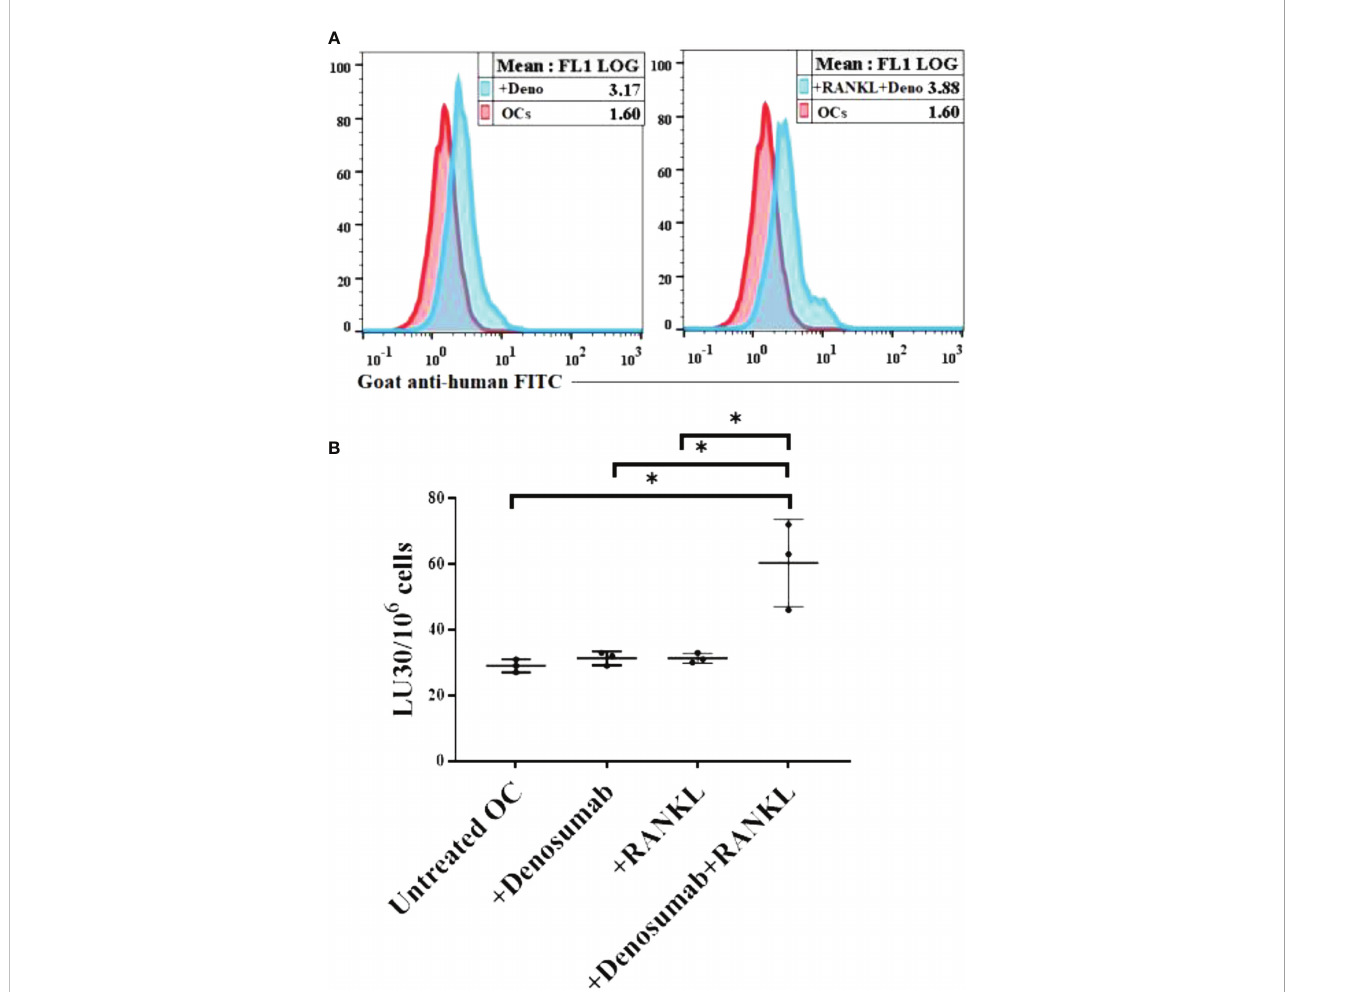
FIGURE 7 Higher levels of NK cell-mediated ADCC was seen against OCs treated with a combination of denosumab and RANKL. Human OCs were generated as described in the Materials and Methods. OCs were left untreated or treated with denosumab (20 m g/ml) or RANKL (25 ng/ml) or a combination of denosumab (20 m g/ml) and RANKL (25 ng/ml) for 30 minutes. The unbounded antibodies were washed away, and the surface expression levels were analyzed after cells were stained with goat anti-human FITC using fl ow cytometry. IgG2 isotype antibodies were used as controls. One of three representative experiments is shown in the fi gure (A) . OCs were generated as described in the Materials and Methods. Puri fi ed NK cells (1×10 6 cells/ml) from healthy individuals were treated with IL-2 (1000 U/ml) for 18 hours and were as effectors in chromium release assay. OCs were labeled with 51 Cr for an hour after which cells were washed to remove unbound 51 Cr. 51 Cr-labeled OCs were then left untreated or treated with denosumab (20 m g/ml) or RANKL (25 ng/ml) or a combination of denosumab (20 m g/ml) and RANKL (25 ng/ml) for 30 minutes. The unbounded antibodies were washed away, and the cytotoxicity against the OCs was determined using a standard 4-6 hour 51 Cr release assay. The lytic units (LU) 30/10 6 cells were determined using the inverse number of NK cells required to lyse 30% of OCs × 100 (n=3) (B) . *(p value